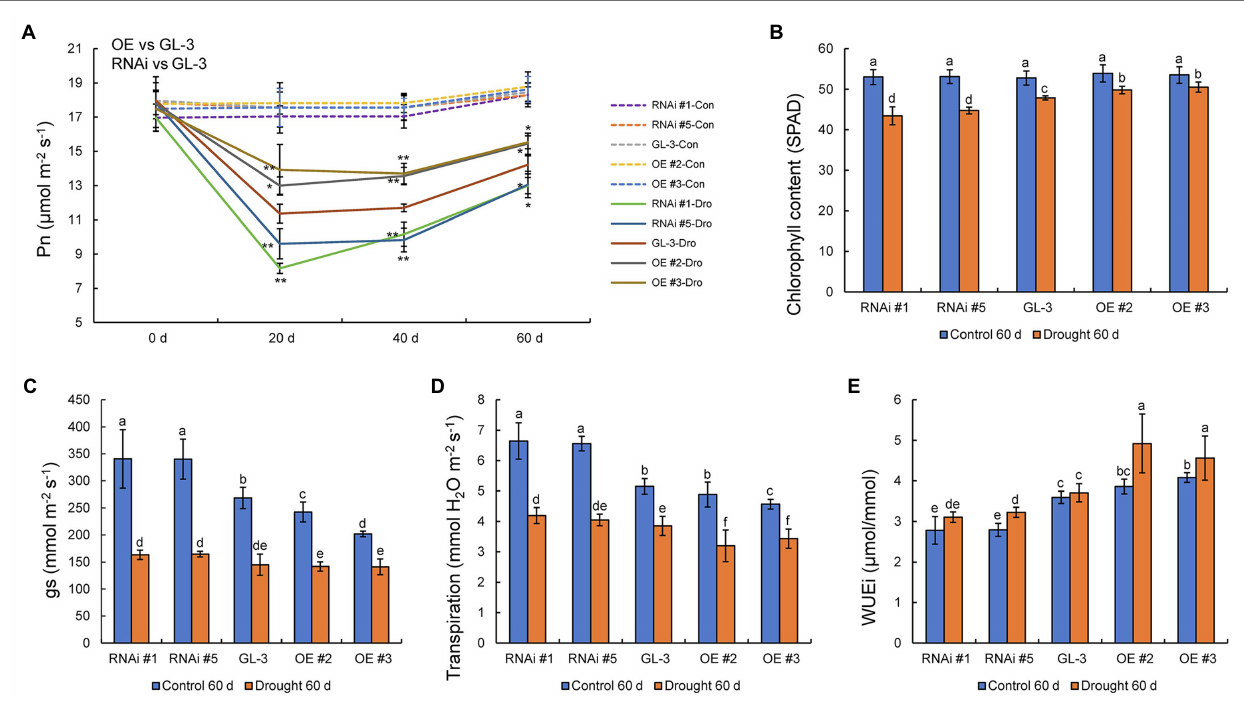
FIGURE 5 | Physiological indices of GL-3 and MdHB-7 transgenic apple plants under well-watered and soil water deficit conditions. (A) Photosynthetic rate (Pn). (B) Chlorophyll content. (C) Stomatal conductance (gs). (D) Transpiration. (E) WUEi. Data are means ± SD ( n = 5 for A–E ). In comparison with GL-3, * p < 0.05 and ** p < 0.01. Different letters indicate significant differences between lines based on one-way ANOVA and Tukey’s multiple range test ( p <